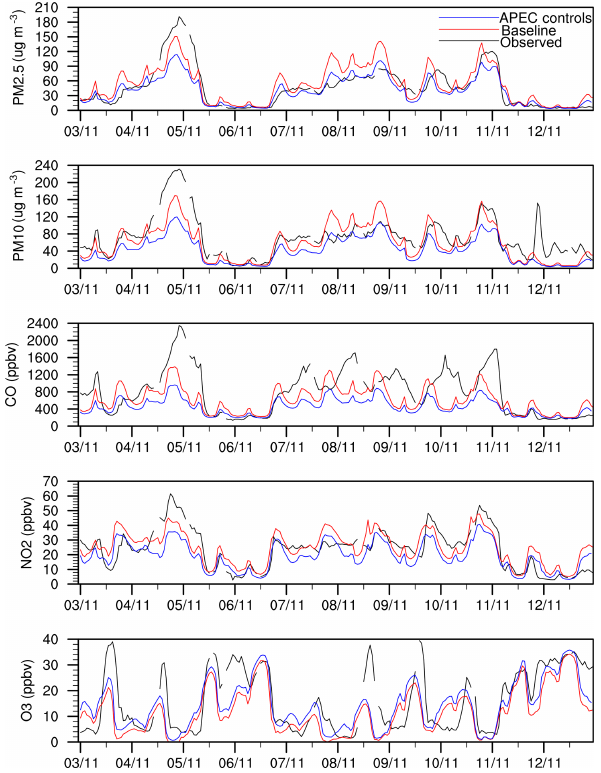
Figure 8. Time series of surface pollutants averaged over the 12 measurement stations in Beijing during the APEC